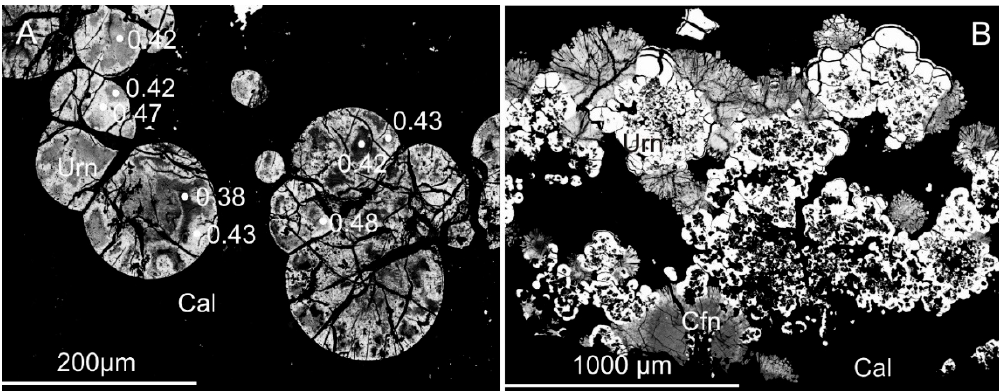
Figure 8. BSE images of uranium mineralization with distribution of Ca ( apfu , O = 4) in uraninite, Zálesí uranium deposit. Urn—uraninite, Cfn—coffinite, Cal—calcite. ( A ) Distribution of Ca in botryoidally evolved uraninite; ( B ) Intergrowths of uraninite with coffinite. The UO 2 content in uraninite from the vein-type ore deposits studied was quite variable, ranging from 65.40 wt % to 81.80 wt %. All other constituents varied significantly: the PbO content varied from 0.10 wt % to 10.81 wt %, SiO 2 from 0.0 wt % to 9.98 wt %, FeO from 0.0 wt % to 4.15 wt % and CaO from 0.69 wt % to 8.31 wt % (Table 1). Concentrations of P, Th and Zr were relatively low: up to 1.11 wt % P 2 O 5 , up to 0.12 wt % ThO 2 and up to 1.79 wt % ZrO 2 . The highest concentration of PbO